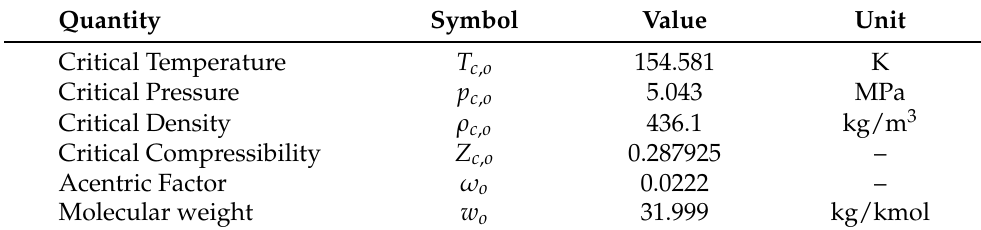
Table 2. Proprieties of molecular oxygen ( O 2